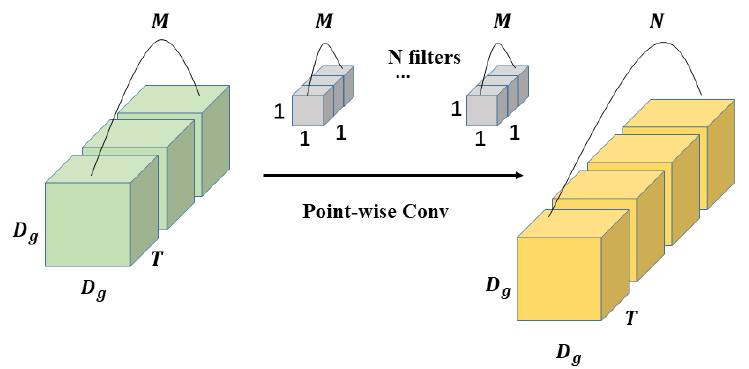
Figure 8. The process of 3D point-wise